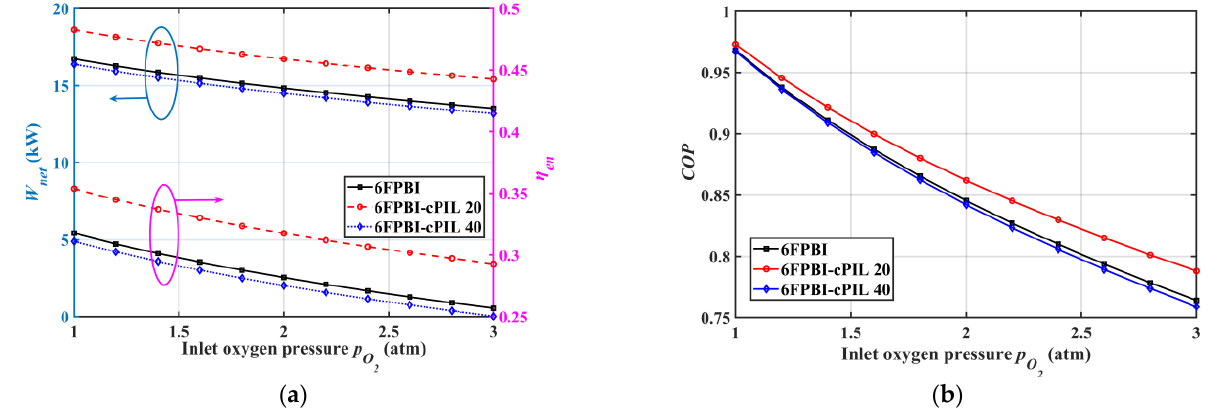
Figure 6. Variation of system performance with inlet oxygen pressure: ( a ) output power 𝑊 𝑛𝑒𝑡 and energy efficiency 𝜂 𝑒𝑛 ; ( b ) the coefficient of performance 𝐶𝑂𝑃 . energy efficiency η en ; ( b ) the coefficient of performance COP